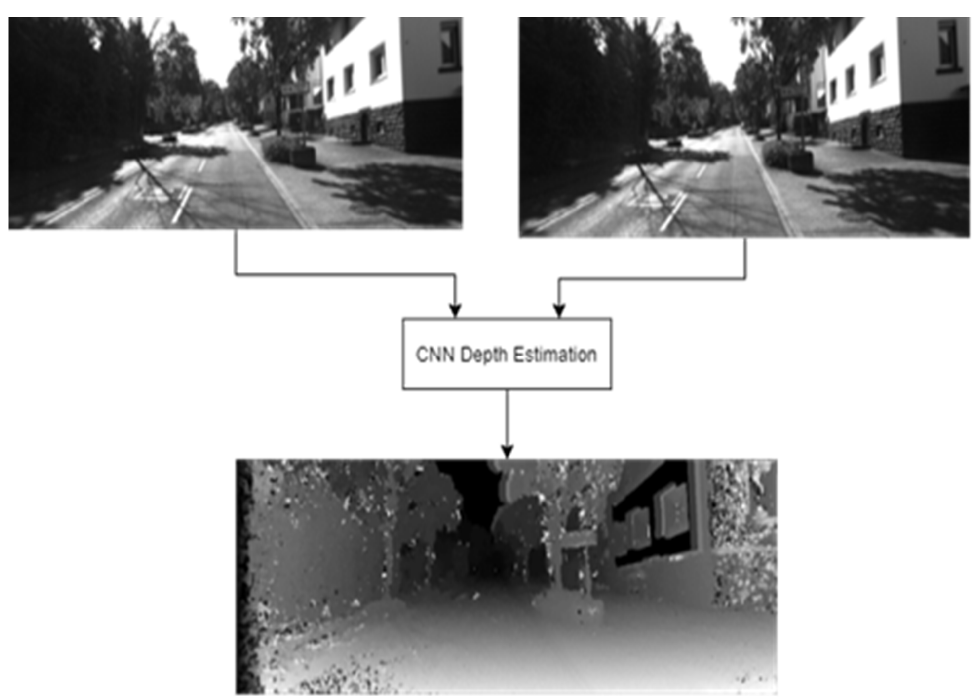
Figure 11. Visual depth map obtained from the network [19].